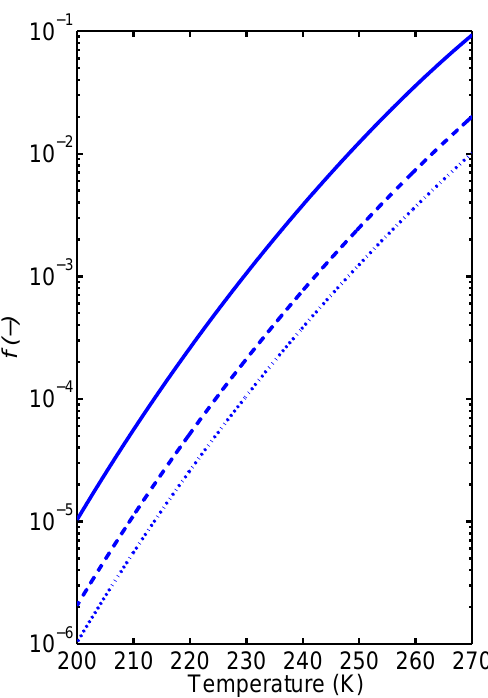
Fig. 7. Retention factor f versus temperature for three different surface area densities of snow: Solid line=10cm − 1 , dashed line: 50cm − 1 and dotted line: 100cm − 1